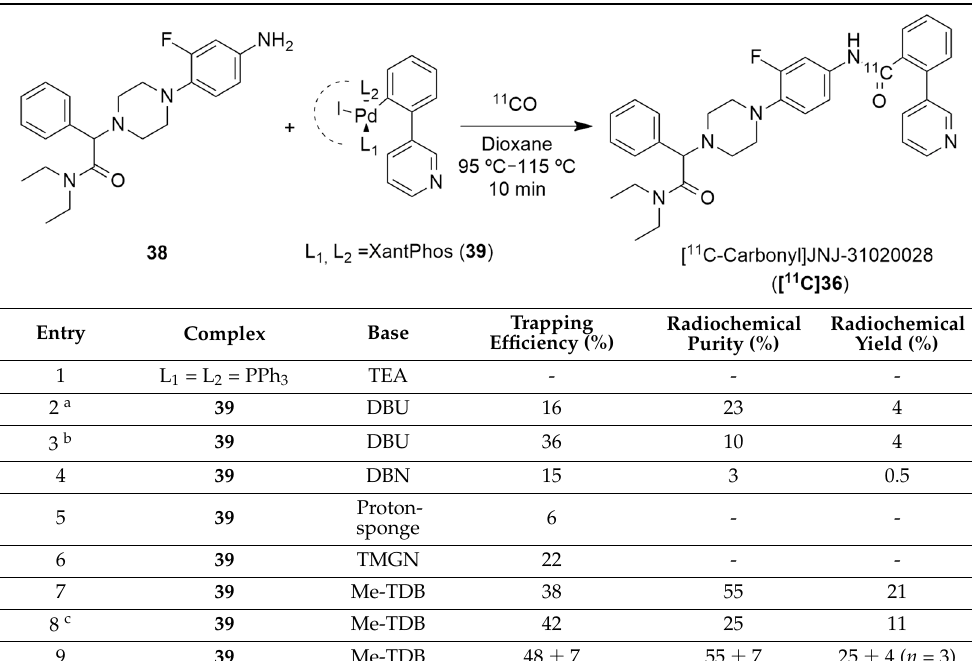
Table 5 . Compound JNJ-31020028 [ 11 C]-Carbonyl